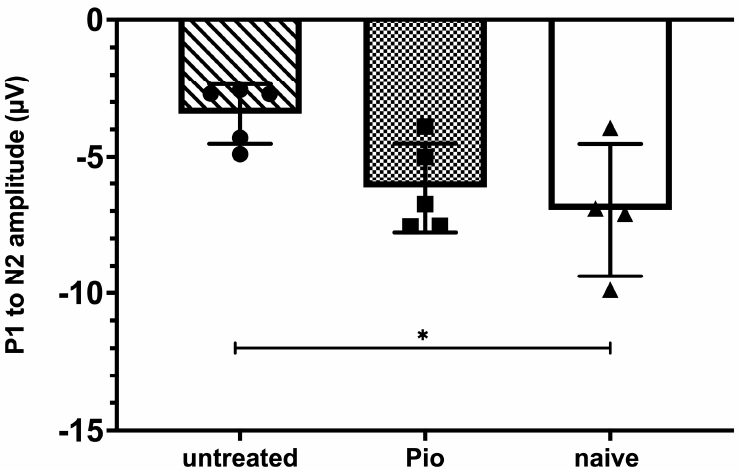
Figure 5. Pattern electroretinography (pERG) after 8 weeks of elevated IOP. The P1 to N2 amplitude is significantly diminished in untreated mice when compared to naïve animals ( p = 0.028). Animals receiving pioglitazone in the drinking water for 28 days before pERG measurements did not display significant differences when compared to naïve mice ( p = 0.72). *: p < 0.05